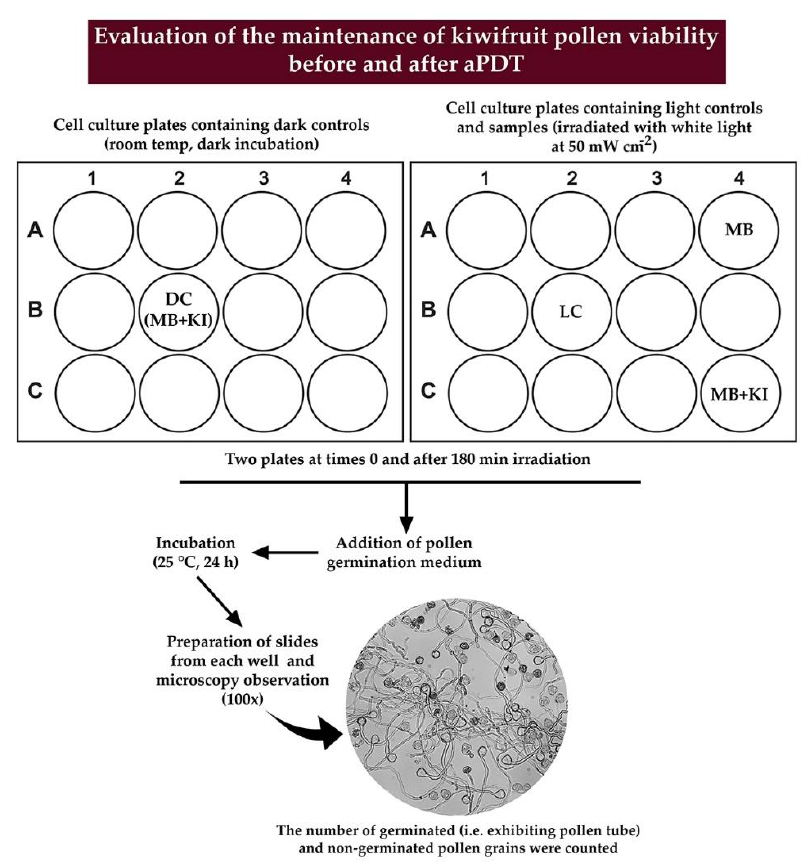
Figure 4. Schematic representation of the experimental procedure used to evaluate the pollen germination after aPDT.